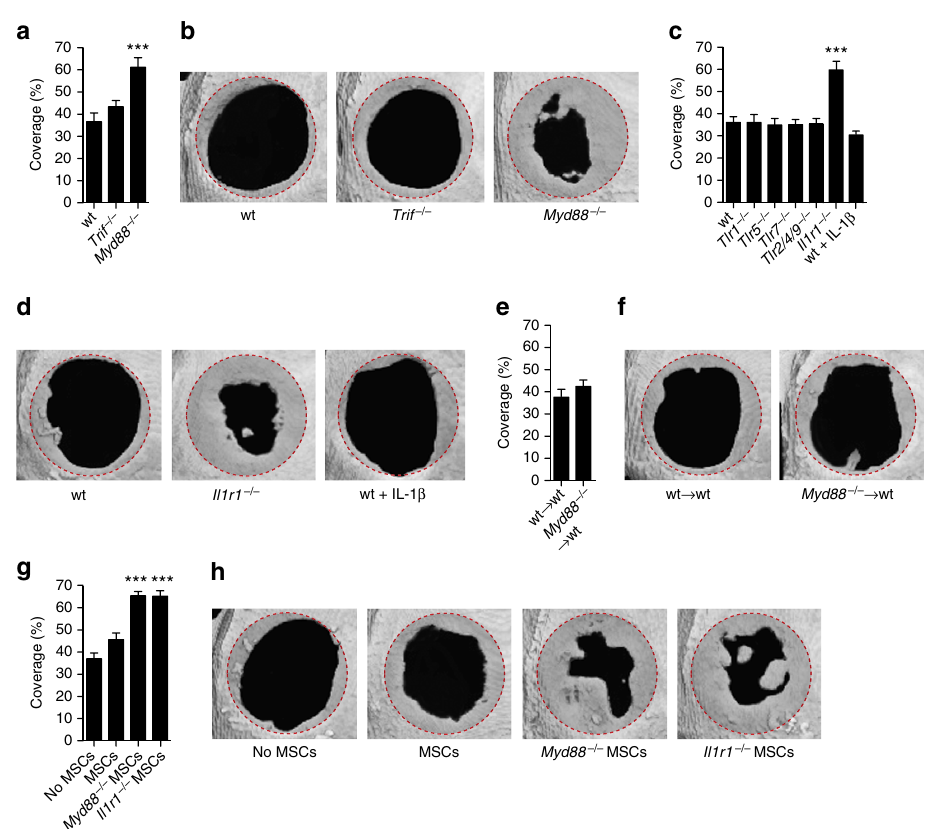
Figure 1 | IL-1R1/MyD88 signalling negatively regulates MSC-driven bone regeneration. Critical size calvarial defects (5mm diameter) in mice were treated with a fibrin matrix. Four weeks after treatment, bone regeneration was measured by microCTas coverage of the defect. ( a , b ) Regeneration in wt, Myd88 (cid:2) / (cid:2) and Trif (cid:2) / (cid:2) mice. ( c , d ) Regeneration in wt, Tlr1 (cid:2) / (cid:2) , Tlr5 (cid:2) / (cid:2) , Tlr7 (cid:2) / (cid:2) , Tlr2/4/9 (cid:2) / (cid:2) (triple knockout), Il1r1 (cid:2) / (cid:2) and in wt mice where 10ng of IL-1 b was co-delivered. ( e , f ) Regeneration in irradiated wt mice having received a bone marrow transplant from wt or Myd88 (cid:2) / (cid:2) mice. ( g , h ) Regeneration in wt mice induced by syngeneic wt, Myd88 (cid:2) / (cid:2) or Il1r1 (cid:2) / (cid:2) MSCs delivered in fibrin matrix. For a , c , e and g , data are means ± s.e.m. ( n Z 6 per condition). ANOVA with Bonferroni post hoc test for pair-wise comparisons; *** P o 0.001. Representative calvarial reconstructions are shown in b , d , f and h . Original defect area is shaded with a red dotted outline. ANOVA, analysis of